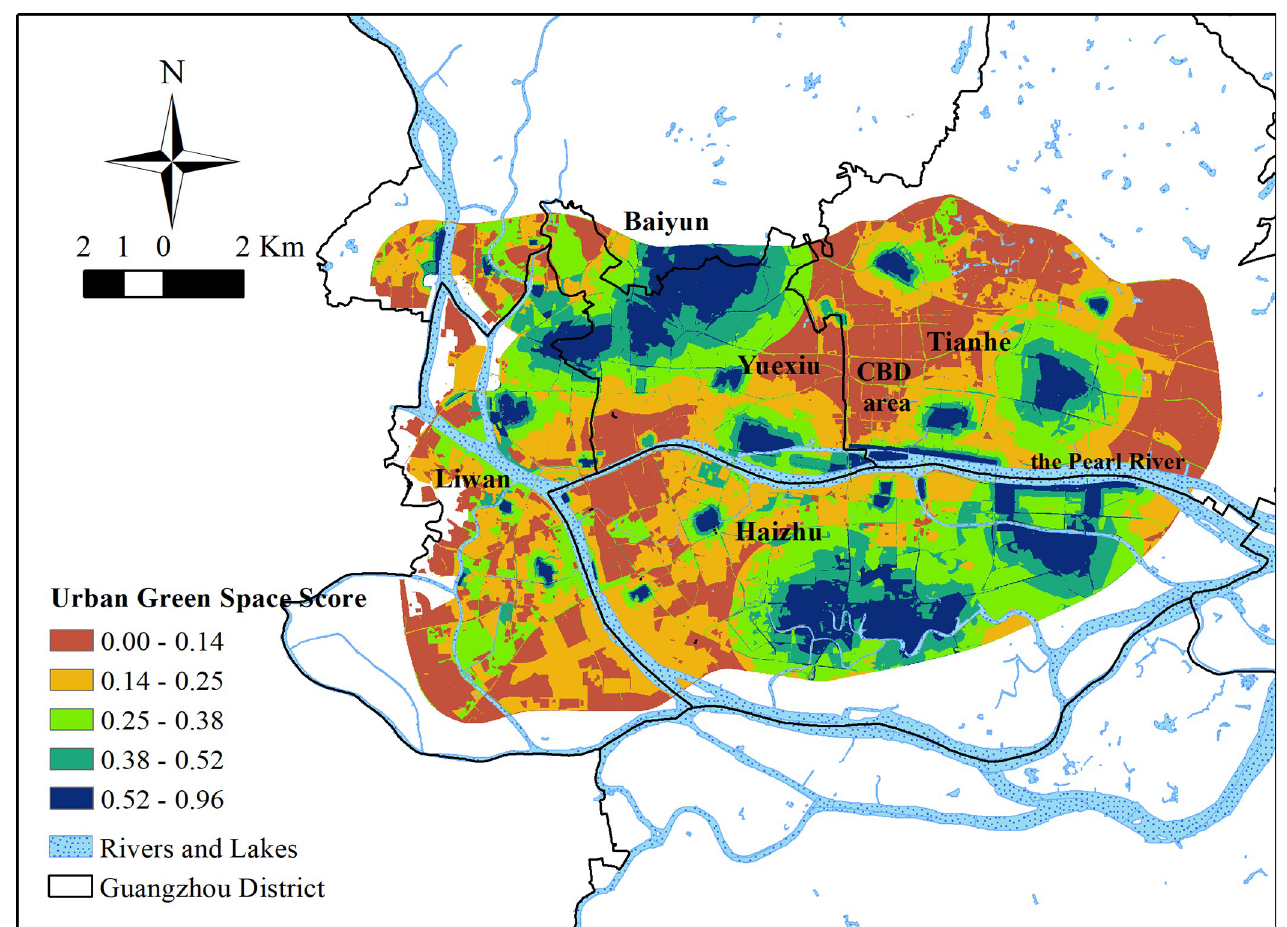
Fig 6. The spatial distribution of